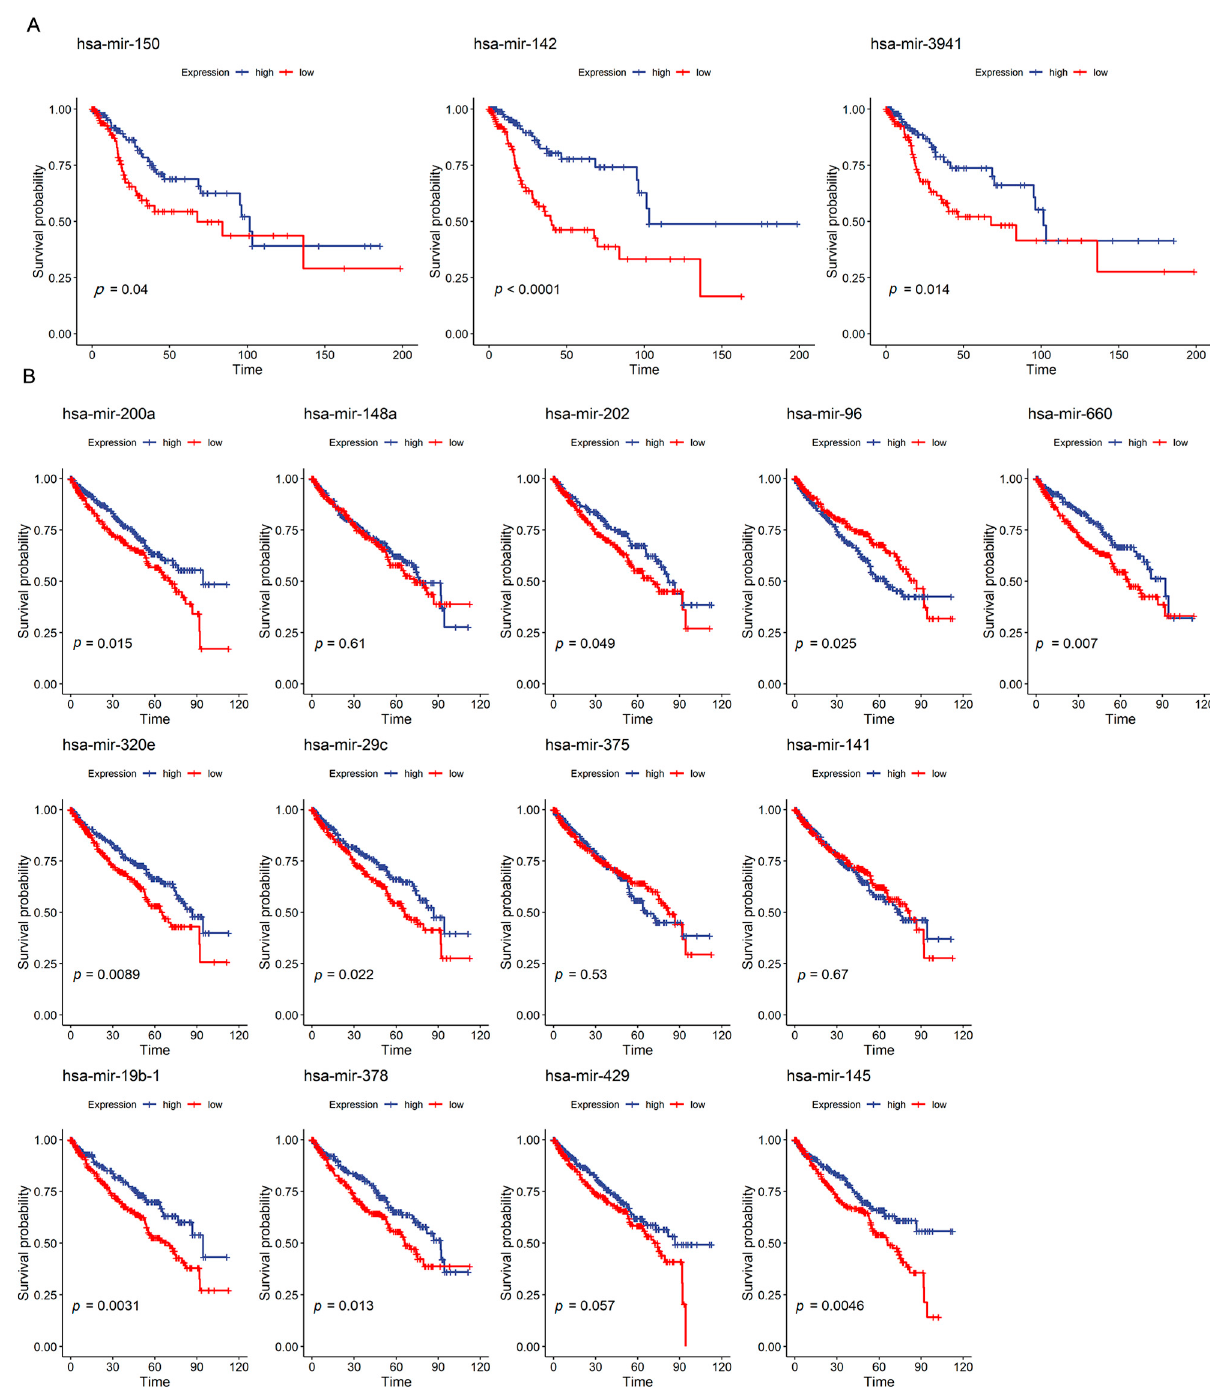
Figure 4. Relationship between T-cell-specific miRNAs and cancer prognosis. ( A ) Survival curves showing the prognostic associations of three T cell chromatin activity-specific miRNAs in CESC. ( B ) Survival curves showing the prognostic associations of thirteen T cell expression-specific miRNAs in KIRC. The red and blue lines indicate miRNAs’ low expression and miRNAs’ high expression,